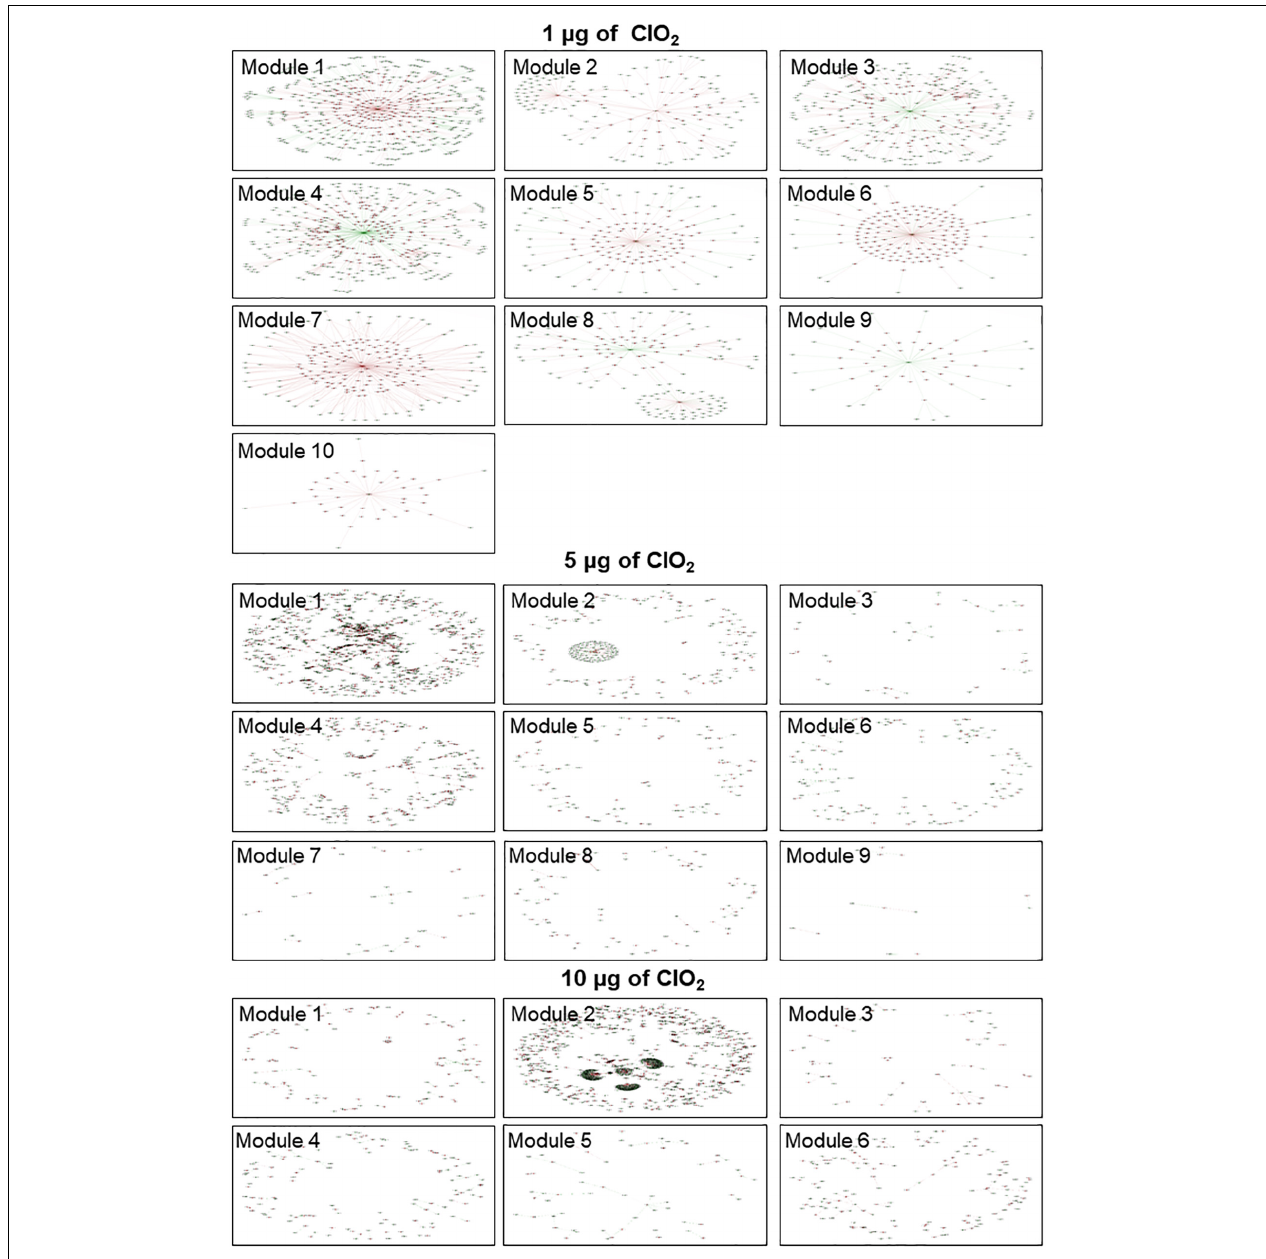
FIGURE 7 | Network view of the E. coli gene co-expression modules. Nine (9) and six (6) modules were presented for 1, 5, and 10 µ g ClO 2 per gram of ripe fruits, respectively. Each node represents a gene and each line denotes the gene expression correlation between the two nodes. Red node denotes genes within the module, green node denotes genes not in the module but co-expressed with the genes within the module. Brown line denotes positive correlation and green line denotes negative